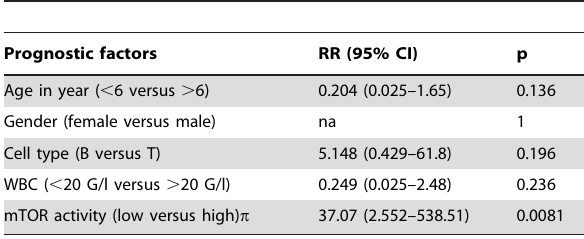
Table 2. Multivariate analysis of various standard independent prognostic factors in ALL cases.